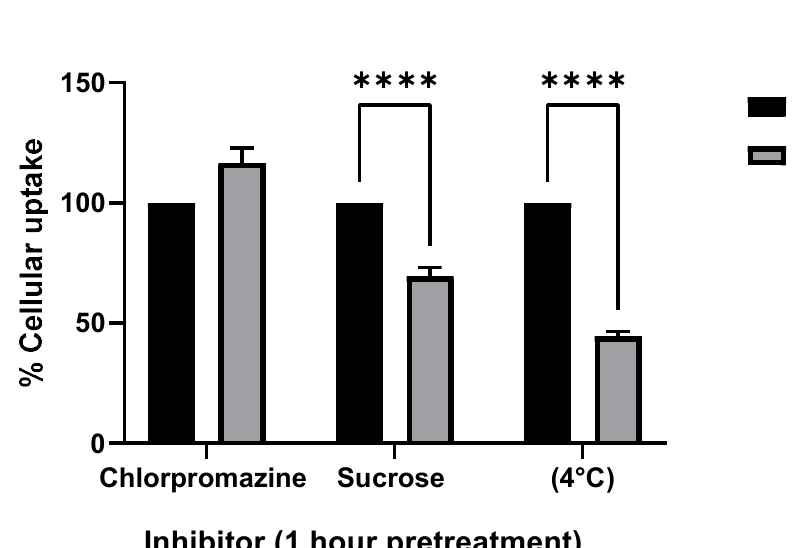
Figure 7. Comparison of endocytosis inhibitor treatments (chlorpromazine, sucrose, and temperature) to determine cellular uptake mechanism in SKBR-3 ( top ) and MCF-7 ( bottom ) cells. Both cell lines were used for cellular uptake of gold nanorods. Chlorpromazine is a known inhibitor for clathrin-mediated endocytosis, and sucrose is an inhibitor of both clathrin-mediated endocytosis and fluid phase macropinocytosis. Treatments at 4 ◦ C were used as a positive control for inhibiting endocytosis. The values shown are averages with standard errors, determined from at least three independent experiments, each conducted in triplicate. (**** less than 0.00005 etc.).